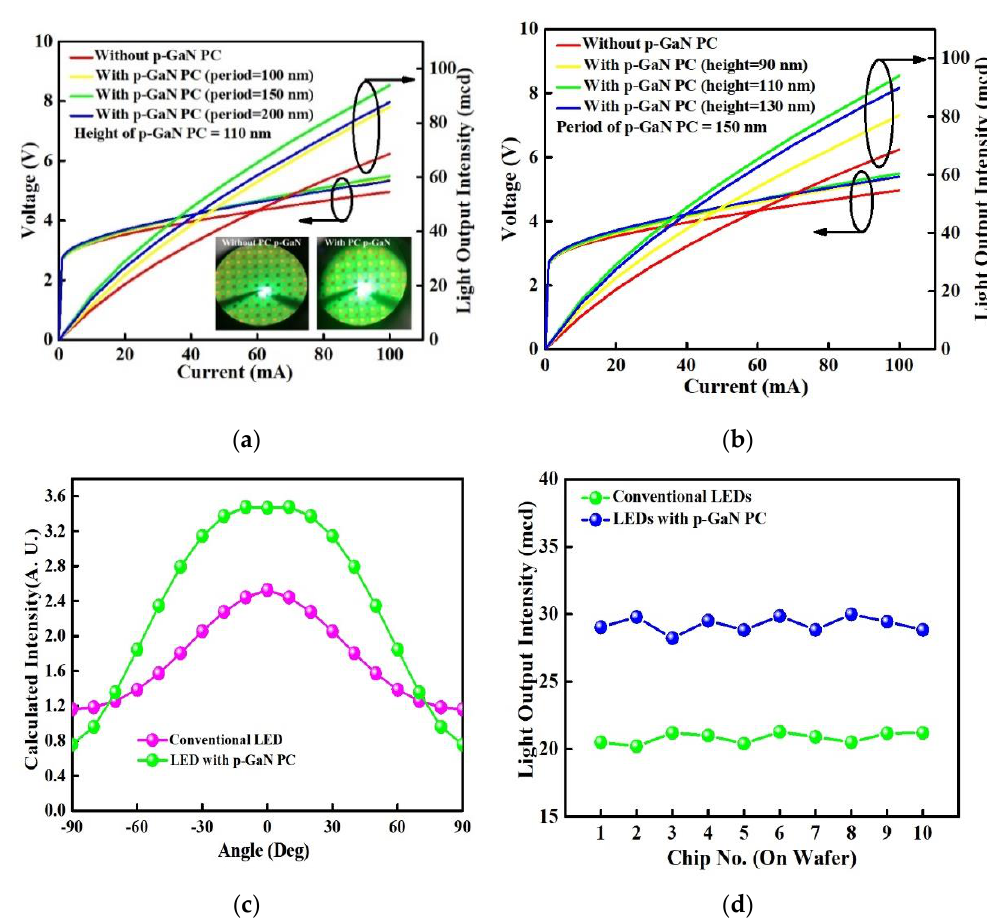
Figure 6. L − I − V measurement for InGaN/GaN green LEDs without and with varied ( a ) period and ( b ) height of the PC-structured p-GaN nanorods. ( c ) The calculated intensity at the measured angle for InGaN/GaN green LEDs without and with the optimal PC-structured p-GaN nanorods at 525 nm, and ( d ) the light output intensity at 20 mA for selected chips on the InGaN/GaN wafer with optimal PC-structured p-GaN nanorods.